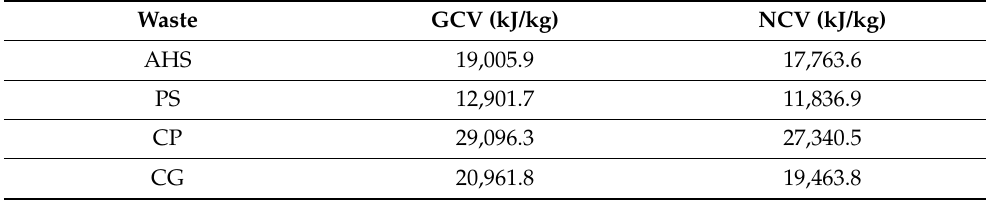
Table 1. Gross and net calorific values of wastes (GCV = gross calorific value; NCV = net calorific